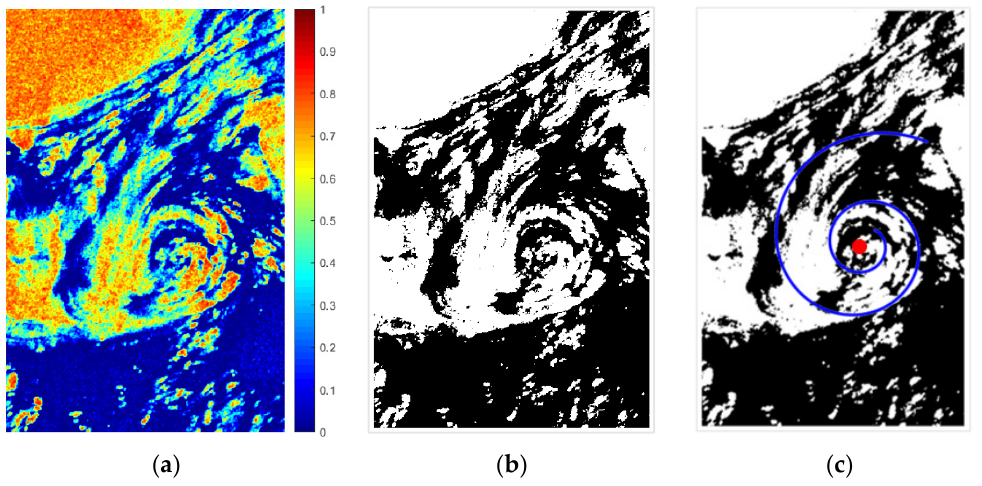
Figure 11. Results of “black” eddy detection and center position extraction in CP feature c 41( 1mHA ) image. ( a ) Eddy region slice in the feature image. ( b ) Eddy detection results based on the k-means clustering algorithm. ( c ) Result of the eddy information extraction. The blue helix is the optimal logarithmic helix obtained by fitting, and the red dot is the obtained eddy center location. Table 6. “Black” eddy detection accuracy.